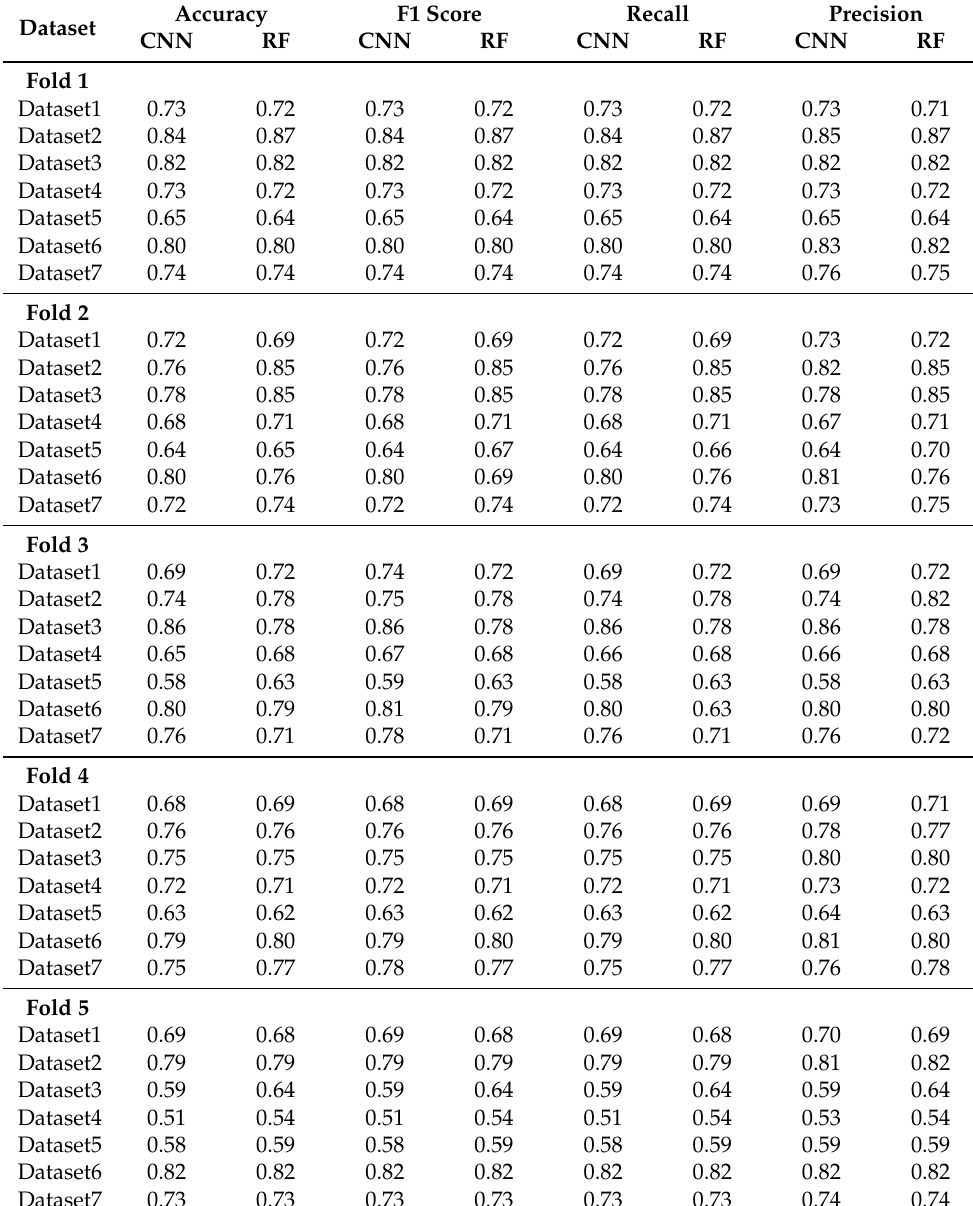
Table 6. Performance metrics CNN vs. RF (from Folds 1 to